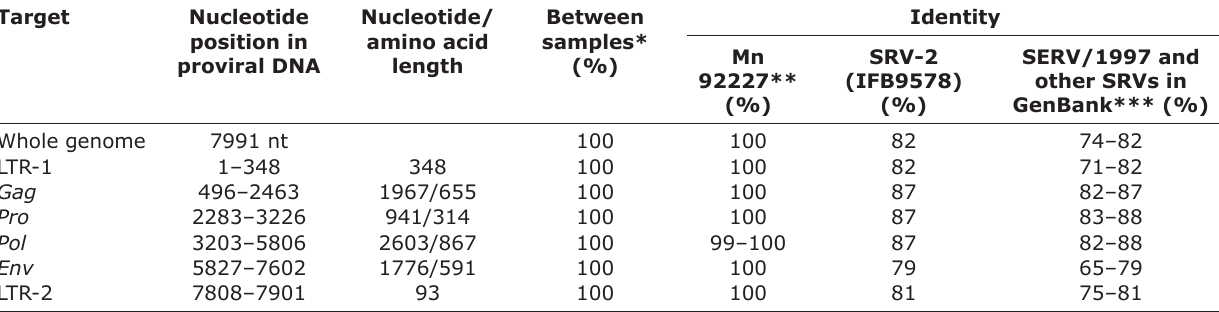
Table-3: Summary of comparison of whole-genome nucleotide identities of the samples obtained in this study with those of SERV/1997 from baboon and other SRVs from GenBank (SRV-1-5 and SRV-8). Target Nucleotide position in proviral